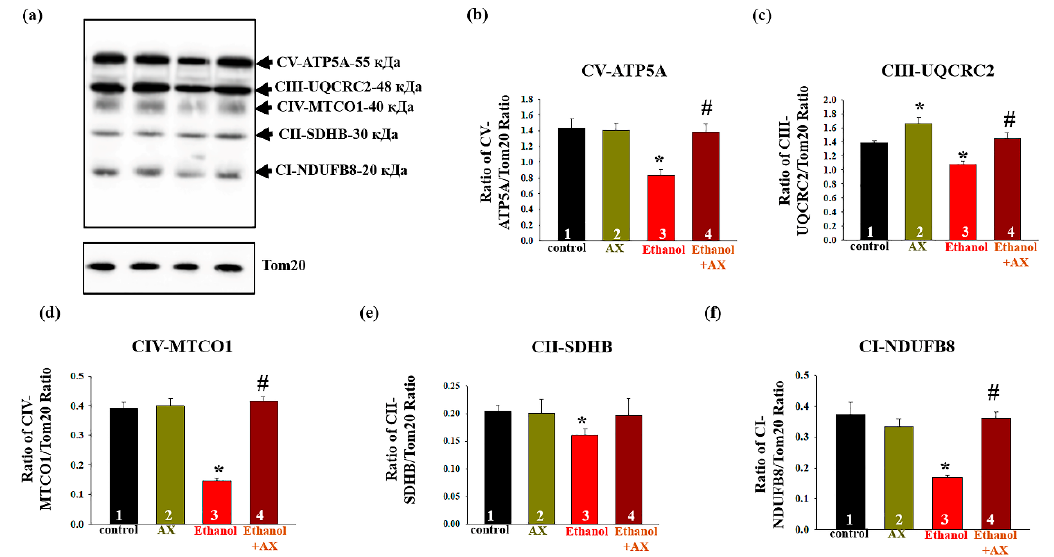
Figure 4. The influence of AX and Ethanol on the change in the levels of the main subunits of the complexes of respiratory chain in RLM. Tom20 was used as a protein load control. ( a )—immunostaining with an antibody cocktail of OXPHOS; ( b – f )—quantification of immunostaining by computerized densitometry presented as a ratio of subunits to Tom20. The data are presented as mean ± SD of three independent experiments. * p < 0.05 indicates a significant difference in the protein level compared to the control (group 1). # p < 0.05 compared with the corresponding value in the RLM isolated from ethanol-administrated rats (Group 3). Statistical significance was assessed using the ANOVA type 2 test (Student–Newman–Keuls).